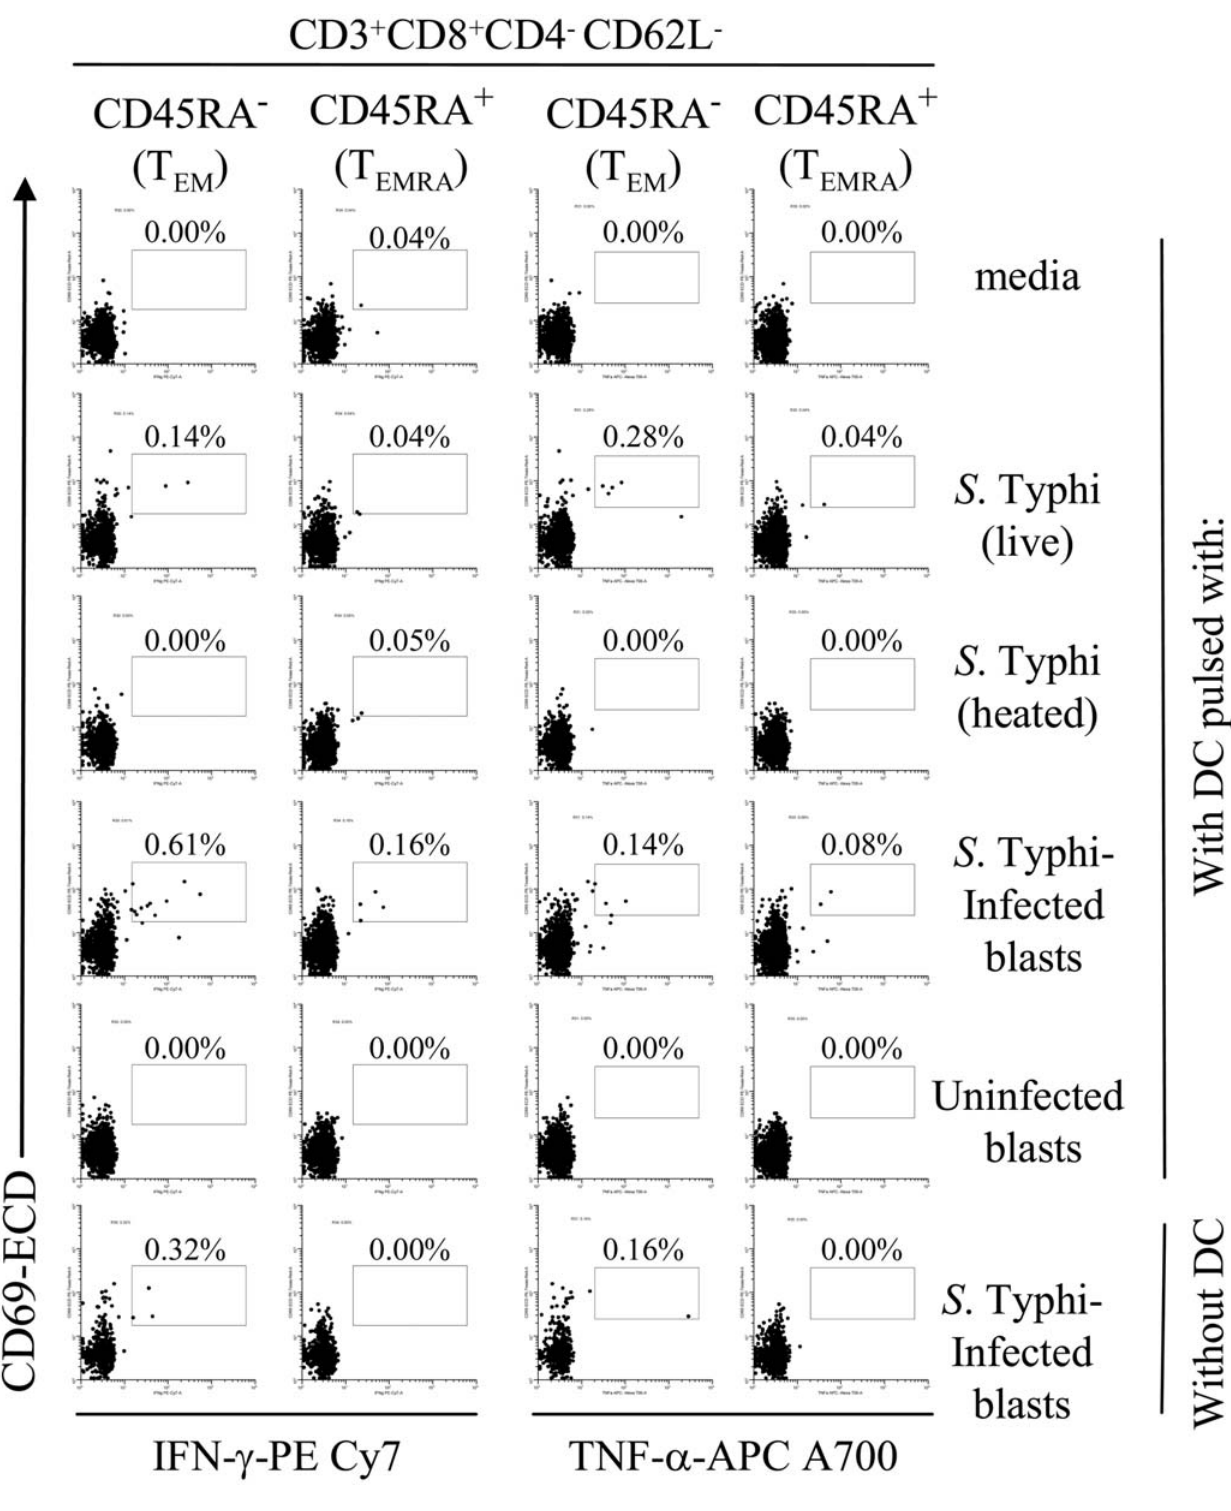
Figure 9. Induction of IFN- c - and TNF- a -secreting CD8 + T cell subpopulations upon DC priming. PBMC from volunteer CVD4000 # 65 were co-cultured with DC alone (media), or pre-mixed with live or heat-killed S. Typhi at a MOI of 10:1, or uninfected or S. Typhi-infected cells at a 1:4 blast:DC ratio. After 20 hours of incubation, cells were surface stained with a combination of mAb to CD3, CD4, CD8, CD14, CD19, CD45RA, and CD62L as well as ViViD. After fixation and permeabilization, cells were intracellularly stained for IFN- c and TNF- a and analyzed by multichromatic flow cytometry. Lymphocytes gated as described in Figure 5 were followed by additional gating on CD3, CD4 and CD8, as well as CDR45RA versus CD62L to analyze T EM and T EMRA cell subsets. Numbers correspond to the percentage of positive cells in the indicated regions in each histogram. These results are representative of 1 of 4 volunteers with similar results.